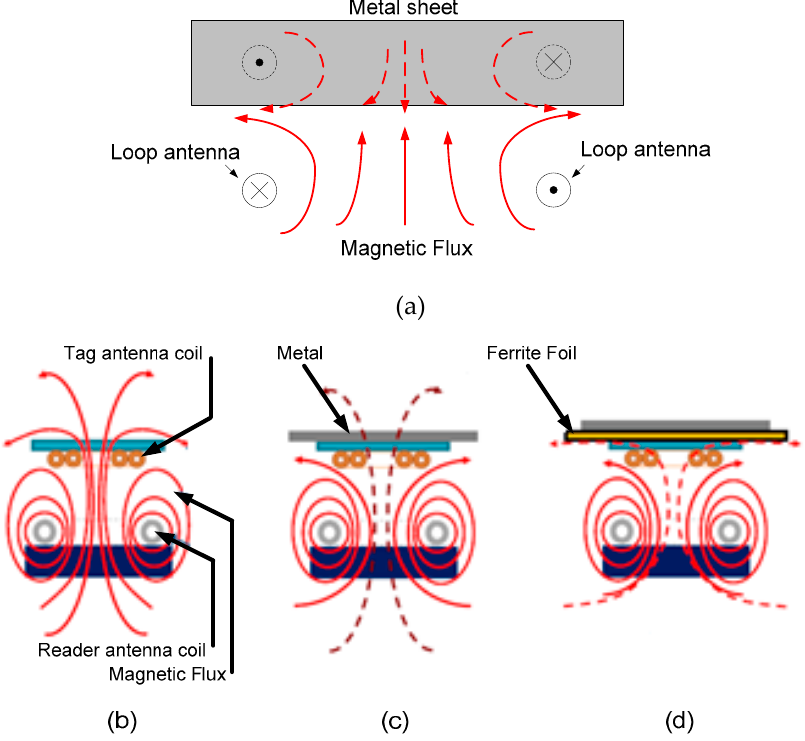
Figure 10. ( a ) Magnetic field on the surface of a metal sheet. Coupling between antennas ( b ) in free space, ( c ) with metal, and ( d ) with ferrite foil.